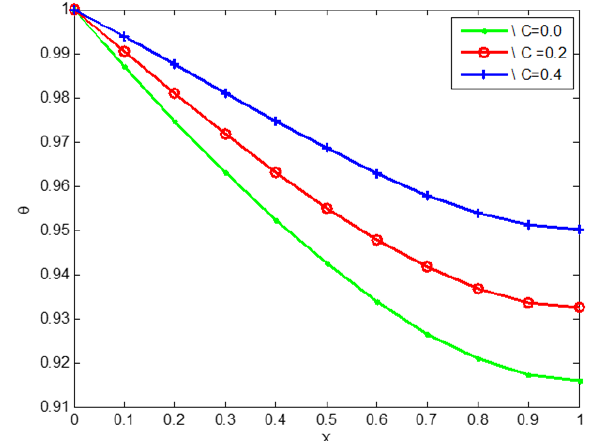
Figure 12. The effect of heat generation parameter on the temperature distribution of a convex copper porous fins